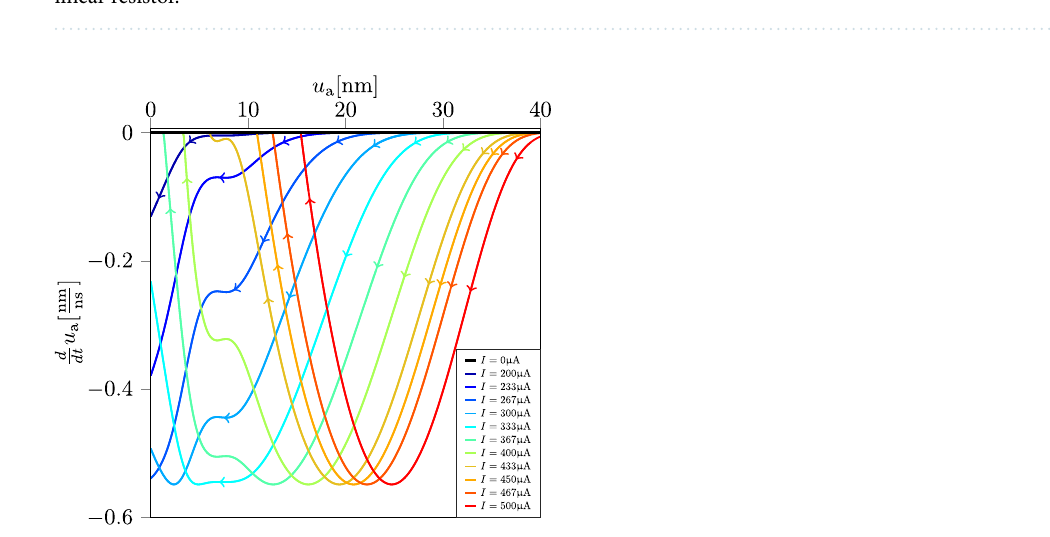
Figure 6. Dynamic route map for PCM. The computed dynamic route map for the PCM device corresponding to write pulses of varying